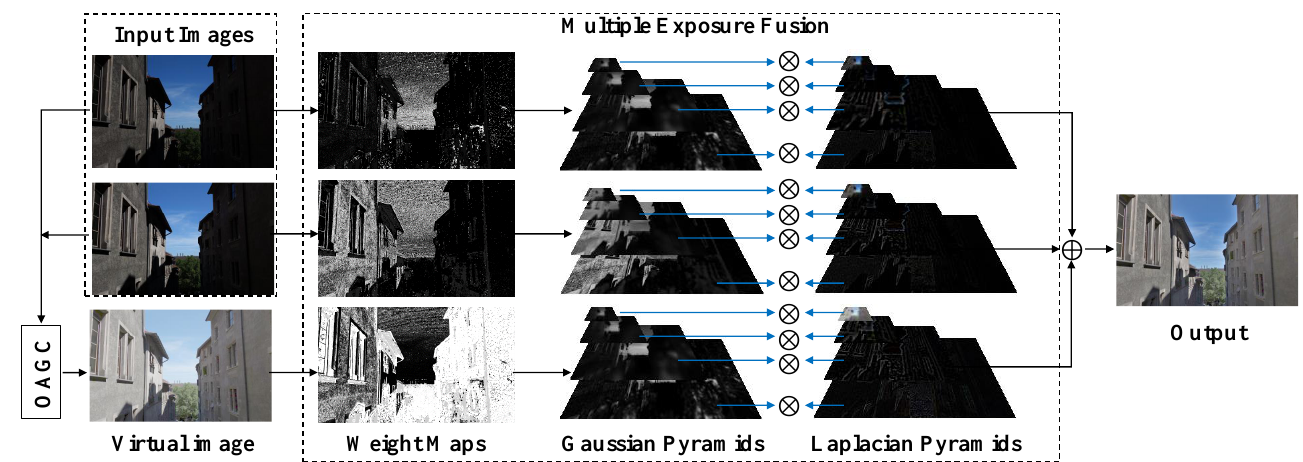
Figure 3. Flowchart of the proposed method. Note that the images of Gaussian and Laplacian pyramids are contrast-enhanced for display.